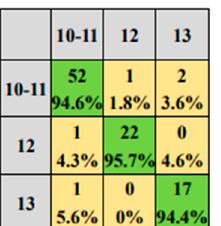
Figure 9. REDD dataset identi fi cation results. ( Green means true, yellow means false )